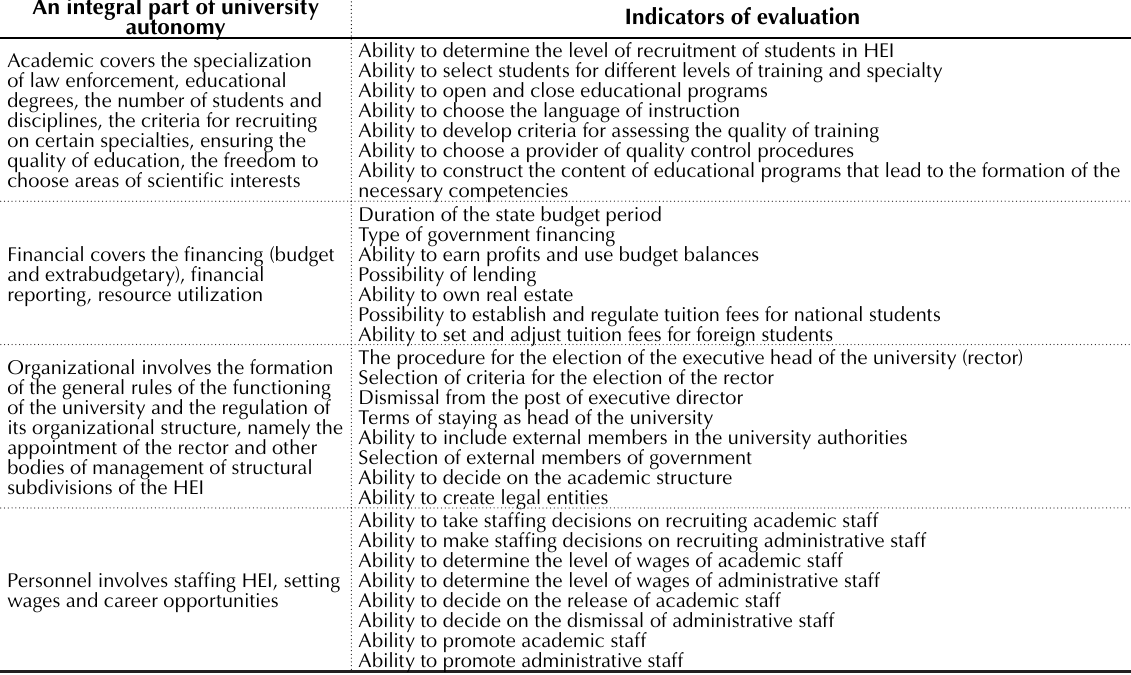
Table 1. Components and indicators for assessing the institutional autonomy of the HEI according to the EUA